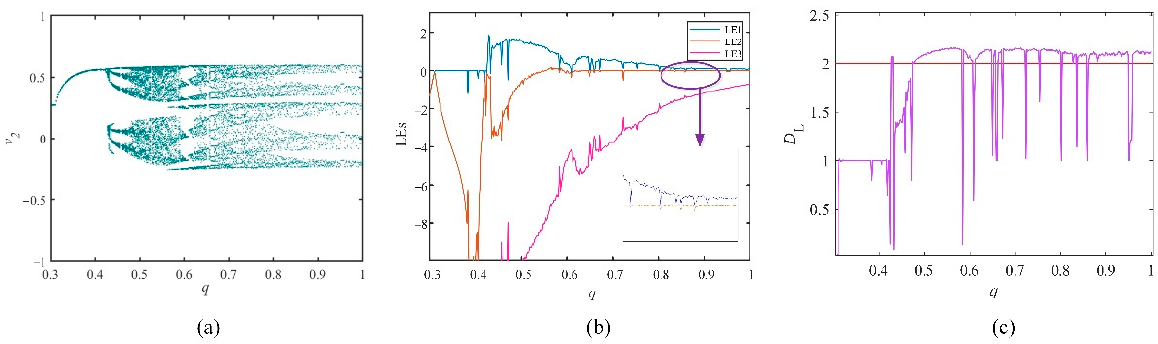
Figure 3. Order q ∈ (0.3,1), β 1 = 0.4, β 2 = 12. ( a ) Bifurcation diagram; ( b ) Lyapunov exponents spectrum; ( c ) Lyapunov dimension.